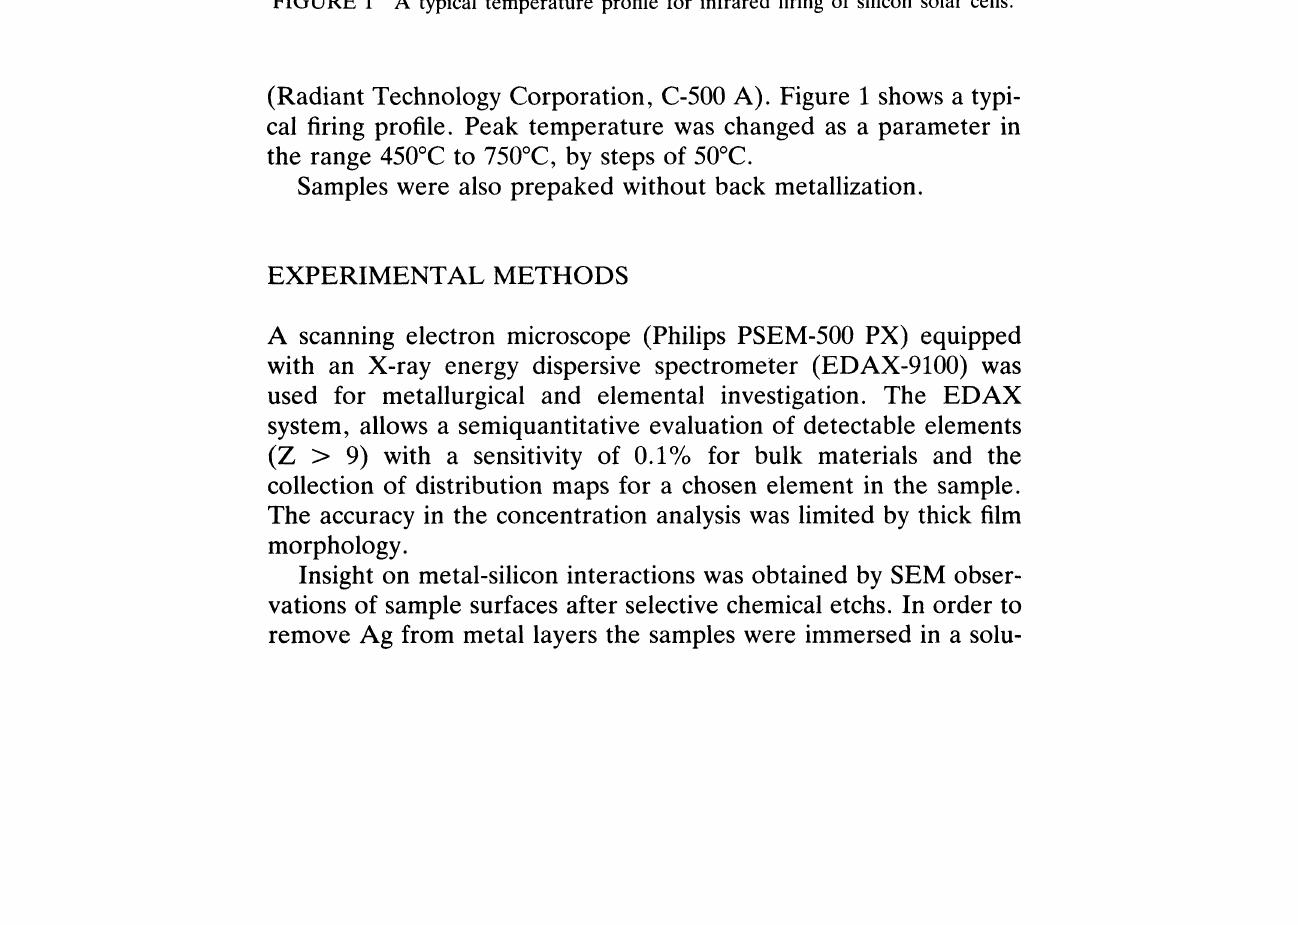
0 5 10 15 20 25 t(min) FIGURE A typical temperature profile for infrared firing of silicon solar cells.